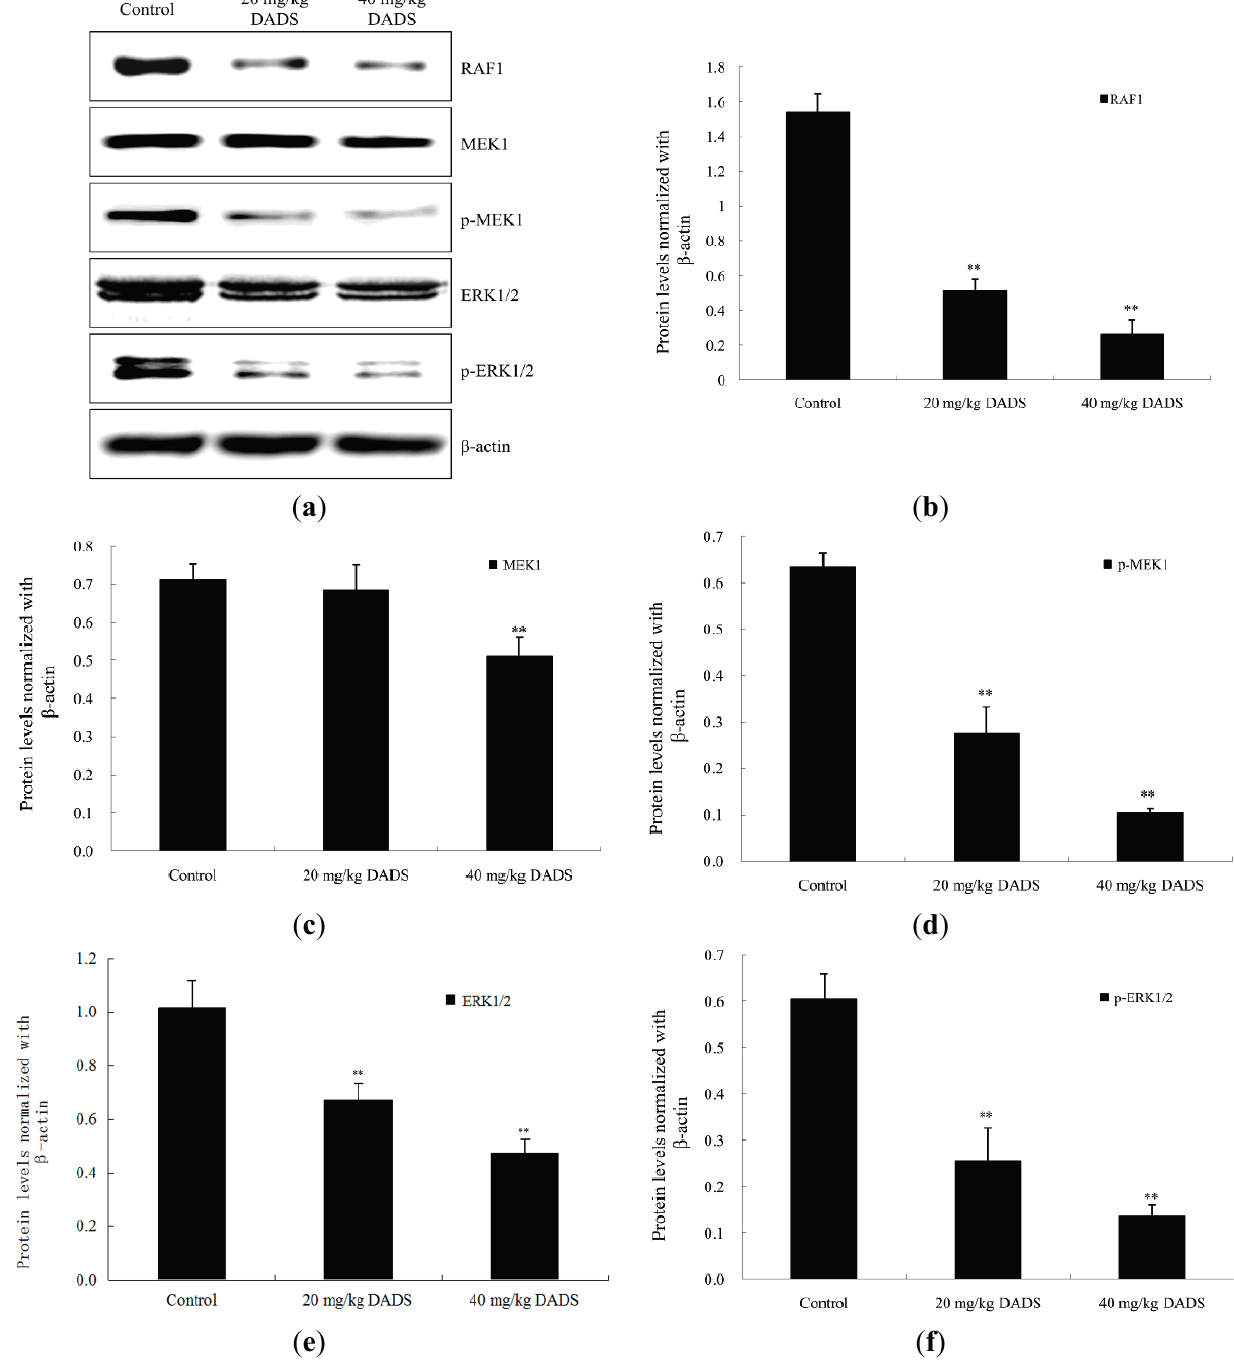
Figure 7. DADS down-regulated RAF/MEK/ERK pathway in ECA109 xenograft tumor. The protein expression levels of RAF1, MEK1, phosphor-MEK1 (p-MEK1), ERK1/2 and p-ERK1/2 from the negative control group, 20 mg/kg DADS group and 40 mg/kg DADS group were assessed by western blot analysis. ( a ) Representative blots. Densitometric analysis was made on the expressions of RAF1 ( b ); MEK1 ( c ); pMEK1 ( d ); ERK1/2 ( e ) and pERK1/2 ( f ). β -Actin was used as the loading control. Data are expressed as the mean ± SD from three independent experiments (** p < 0.01 compared with the control